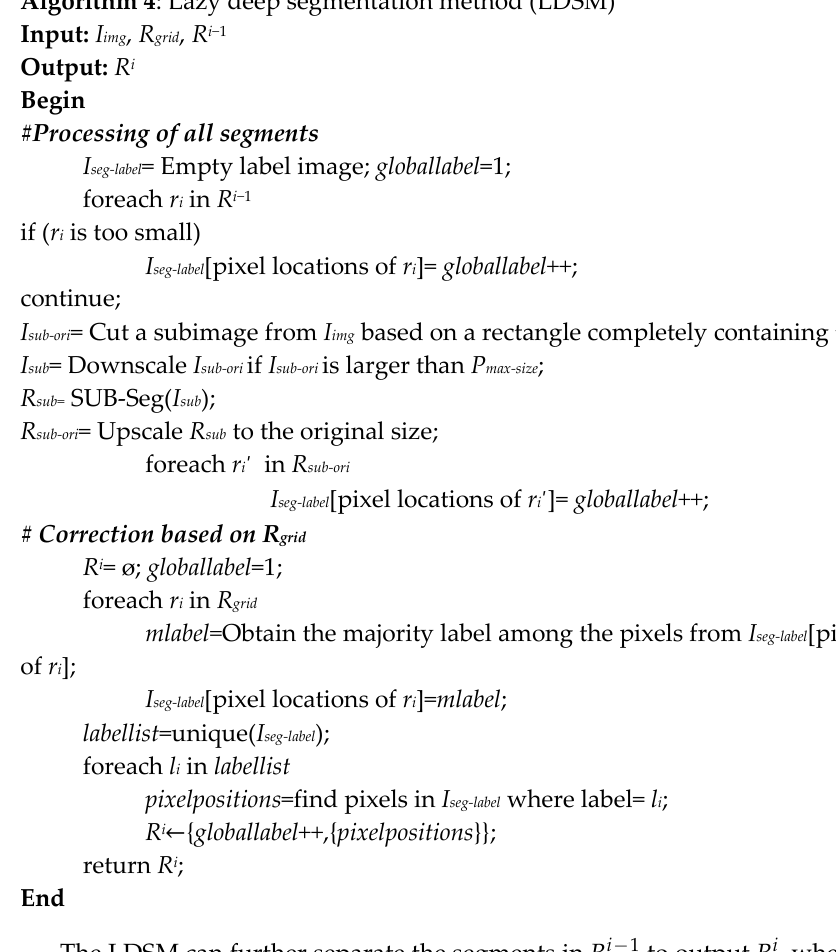
Algorithm 4 : Lazy deep segmentation method